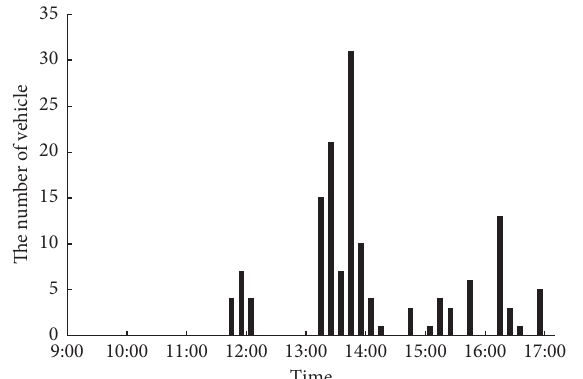
Figure 5: Distribution plan between Le Song Plaza Commercial Building and Triumph Square.